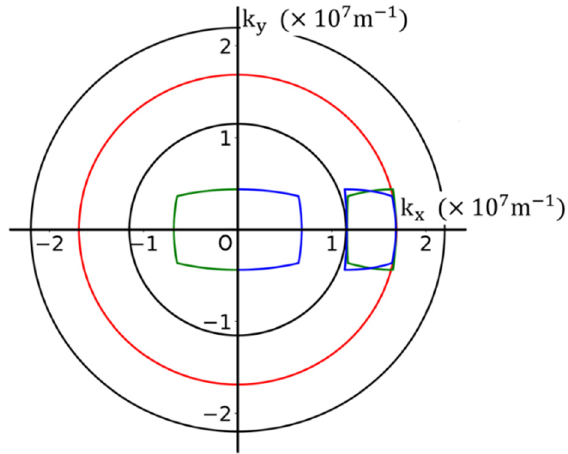
Figure 4. Diagram of k -domain calculated when λ = 546 nm, n wg = 1.91048, and N TIR = 5. Green/blue rounded rectangle denotes the left/right-half FOV, innermost circle the theoretical boundary in air, and intermediate/outermost circle the practical/theoretical boundary in waveguide.